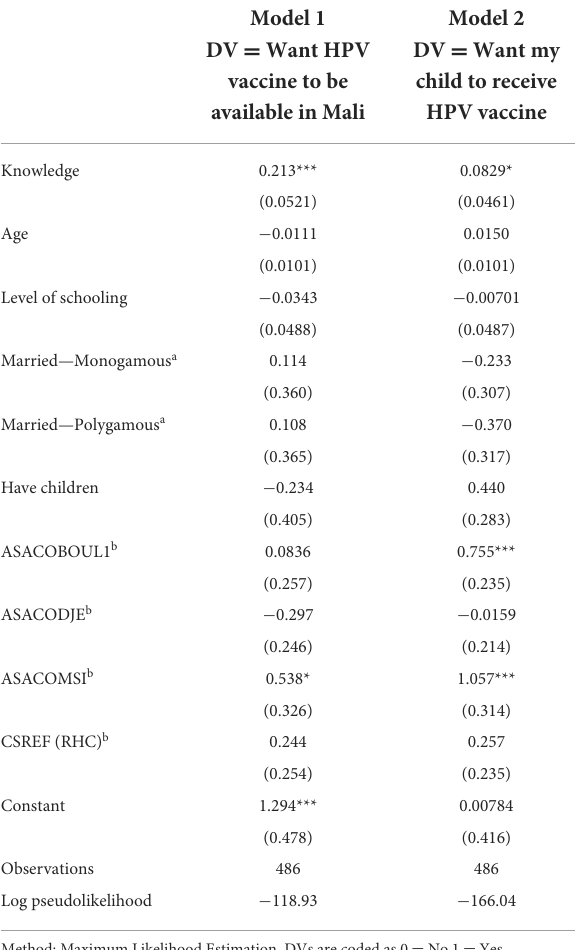
TABLE 6 Probit models evaluating the impact of knowledge on vaccine desirability.